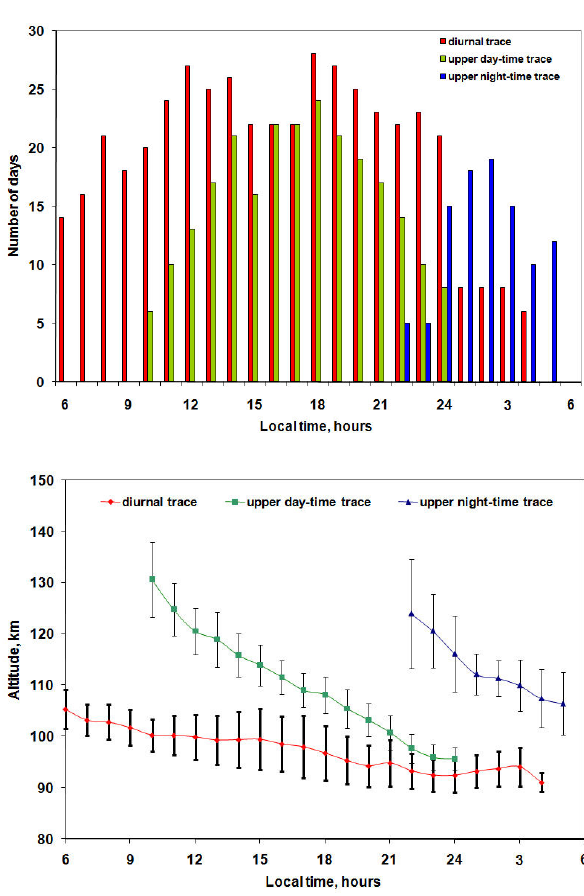
Fig. 6. Same as in Fig. 4 but for summer (June, July, August). See also text for more details.